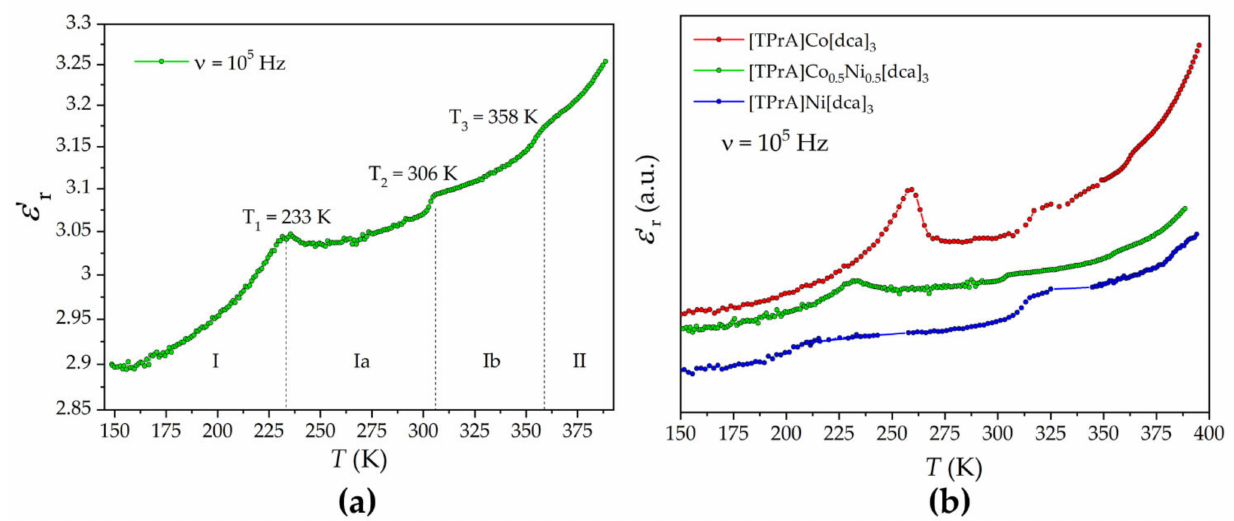
Figure 7. ( a ) Dielectric constant of the [TPrA][Co 0.5 Ni 0.5 (dca) 3 ] material during heating from 148 K to 390 K. ( b ) Dielectric constant comparison between [TPrA][Co x Ni 1 − x (dca) 3 ], where x = 1.0, 0.5 and